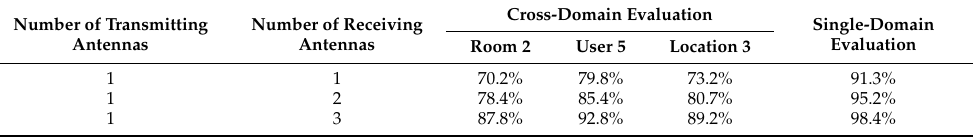
Table 8. The influence of the number of antennas on the performance of cross-domain recognition. Number of Transmitting